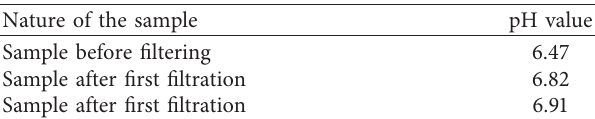
Figure 11: Filter using GO nanoparticles. Table 1: pH value at different stages.